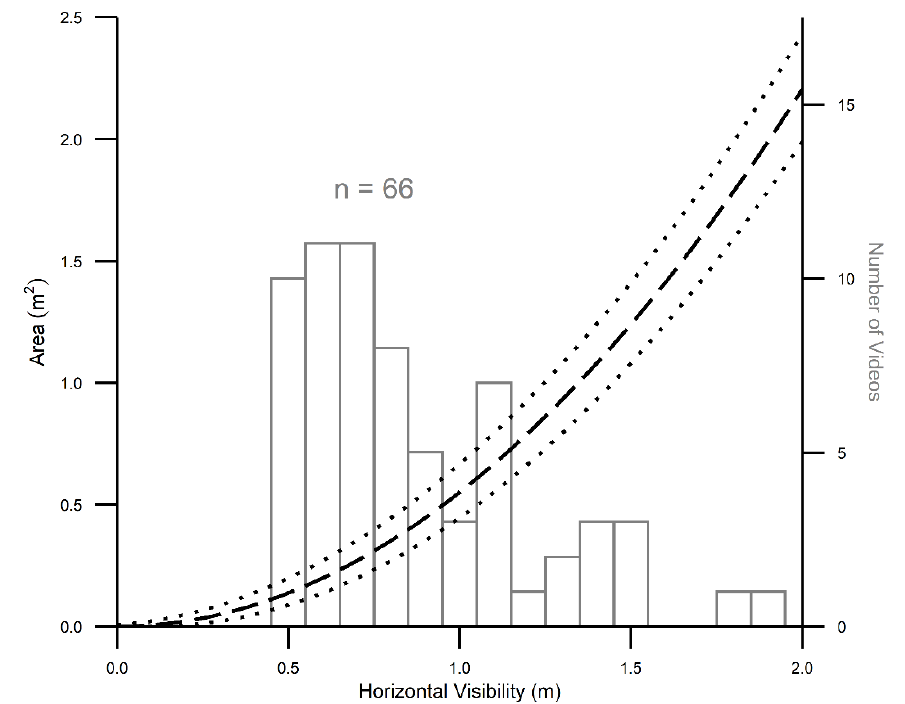
Figure 5. Relationship between horizontal visibility and area sampled in the field of view of underwater video samples (dashed line). Dotted lines indicate error in calculated area assuming a horizontal visibility error of ± 0.1 m based on repeated estimates by multiple observers. Histogram shows the distribution of visibility ranges for the 66 visibility videos with visibility ≥ 0.5 m from East Bay.